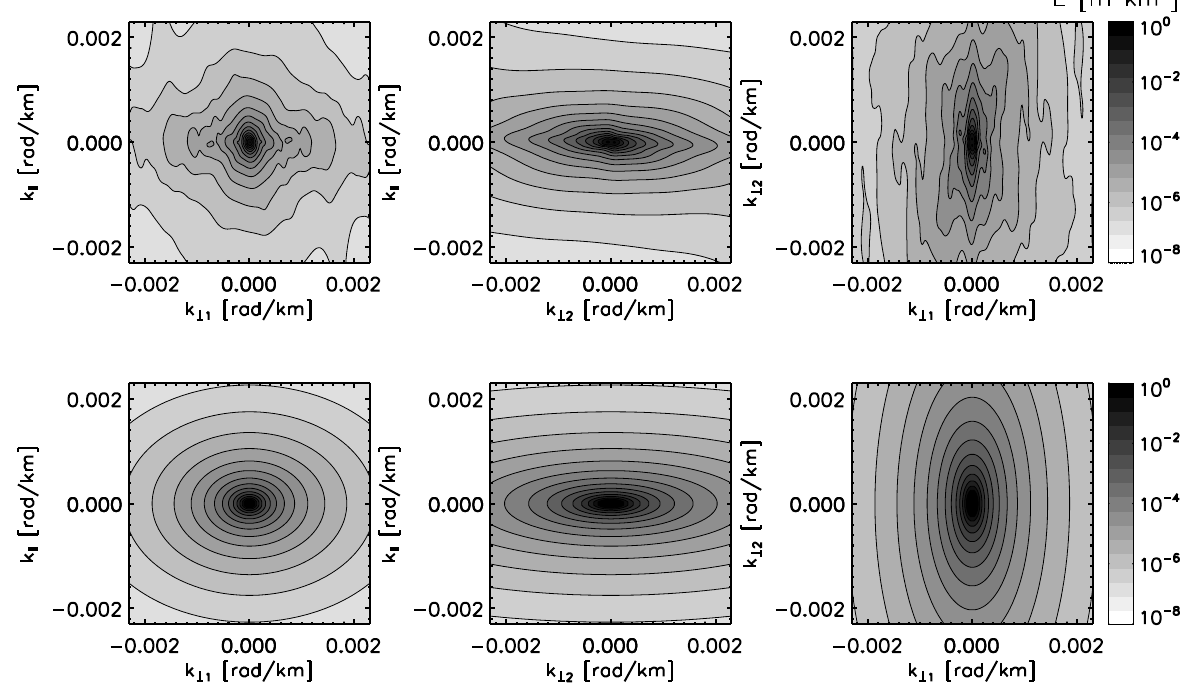
Fig. 5. Slices of the energy spectrum in the 3-D wave vector domain using Cluster spacecraft data in the solar wind (upper panels), and its reconstruction using the model spectrum (lower